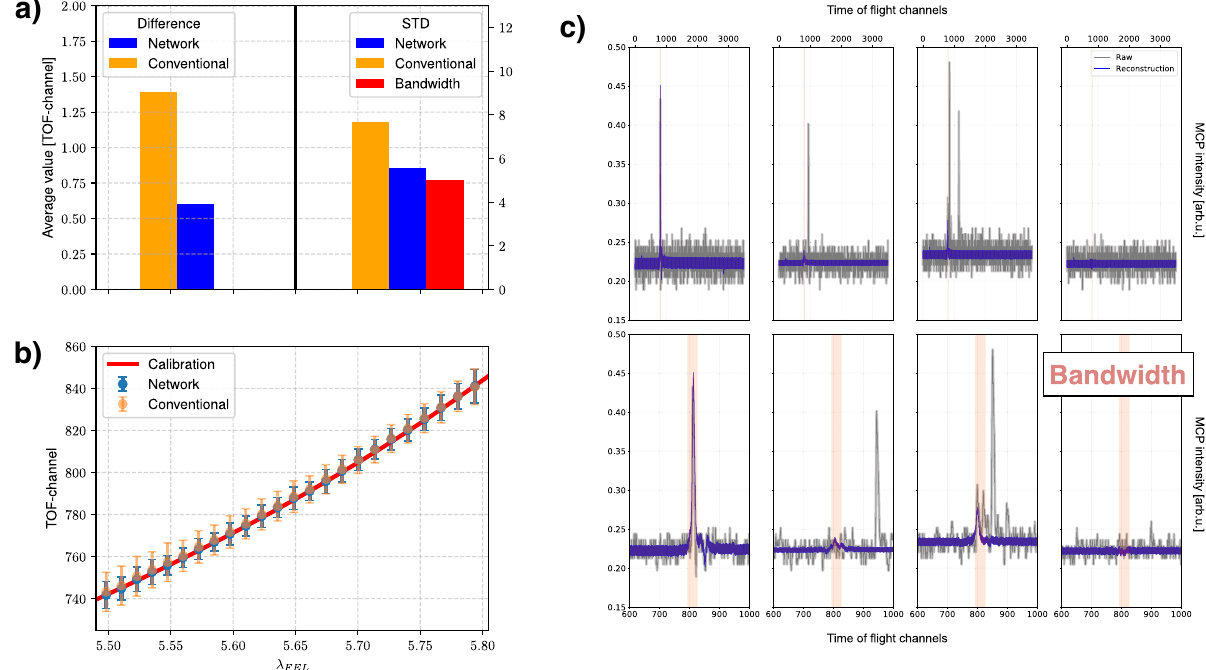
Figure 3. Comparison of the performance between the traditional analysis and the neural network: ( a ) The average difference of the network’s prediction of the time-of-flight position (blue) compared with the expected position at the given (cid:31) FEL from the calibration is significantly lower than the average error given by the traditional analysis (orange). The expected bandwidth is transformed to the STD in TOF channels (red). The STD from the neural network’s predictions are almost identical to the bandwidth. ( b ) For the 25 (cid:31) FEL , the determined TOF-positions of the network and of the traditional analysis are compared with a calibration curve according to the OPIS instrument calibration, which was independently determined in the instrument commissioning campaigns. ( c ) An example shot (grey) is shown which has several peaks at different positions in the eTOFs. The expected position within the given bandwidth is shown in red. While traditional analysis cannot decide which of the peaks to designate as real photoelectron signal, the network reconstructs the peaks at the correct position while ignoring all other peaks in the raw